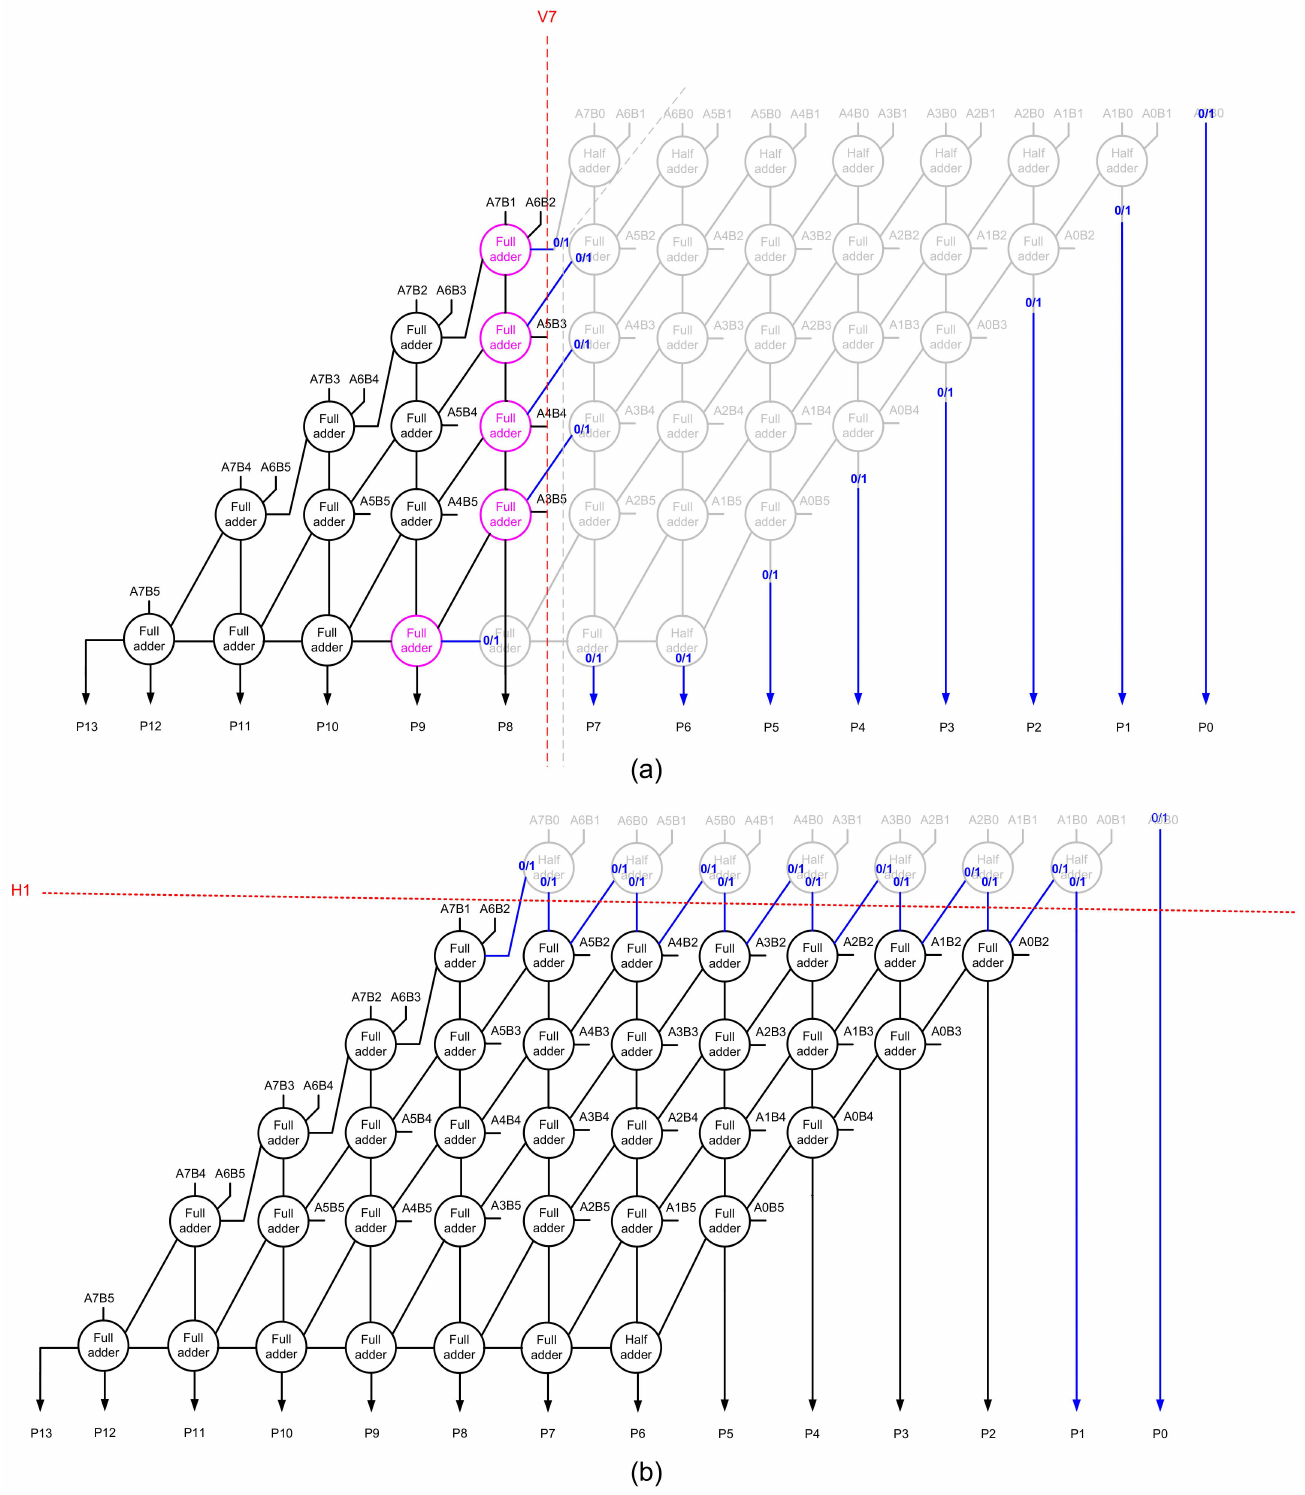
Figure 3. Illustrating the effect of example vertical and horizontal cuts on an accurate array multiplier resulting in approximate array multipliers. ( a ) Vertical cut V7; ( b ) horizontal cut H1. The circuit portions eliminated are shown in light